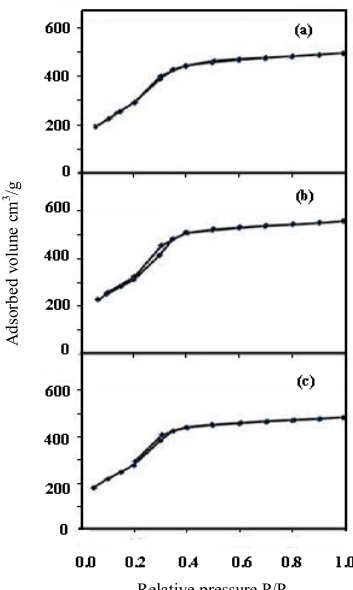
Figure 2. Nitrogen adsorption-desorption isotherms : (a) Al-MCM-41, (b) Co(acac) MCM-41 and (c) Co(bpy) 22+